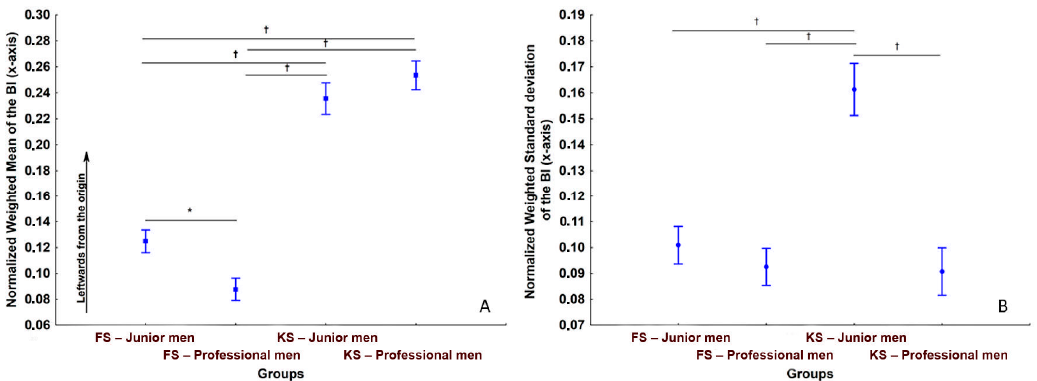
Figure 4. Differences in the ball impact location on the x -axis (professional and junior men). Note: FS—flat serve; KS—kick serve; * Significant differences, p < 0.05.; † Significant differences, p < 0.01; Vertical bars denote 95% CIs. Note: ( A ) normalized weighted mean of the ball impact, ( B ) normalized weighted standard deviation of the ball impact.